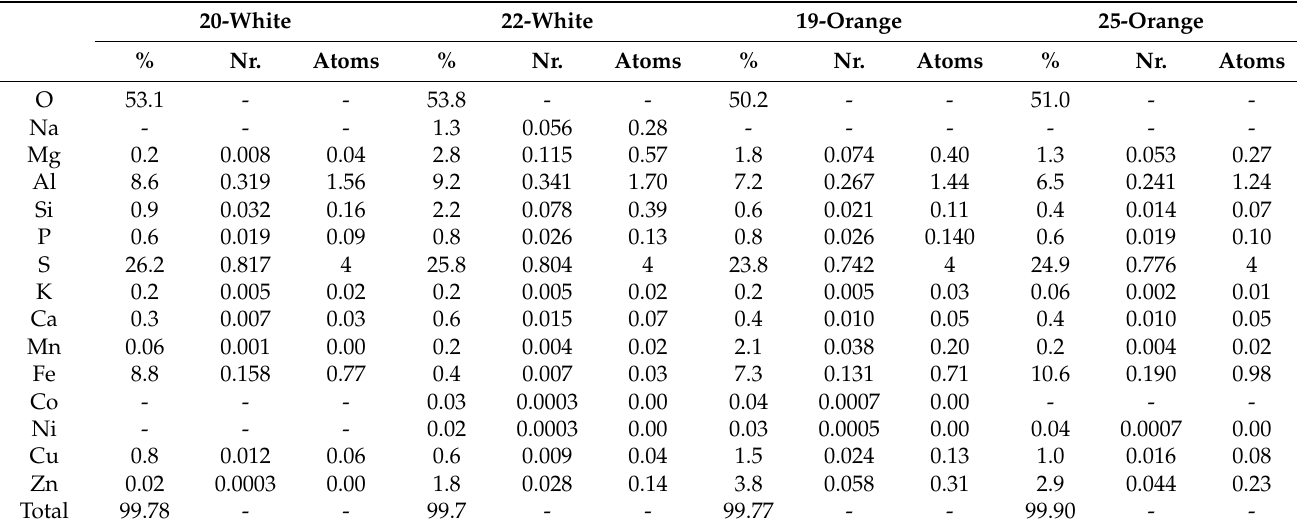
Table 2. Chemical characterisation obtained through XRF of efflorescence salts.